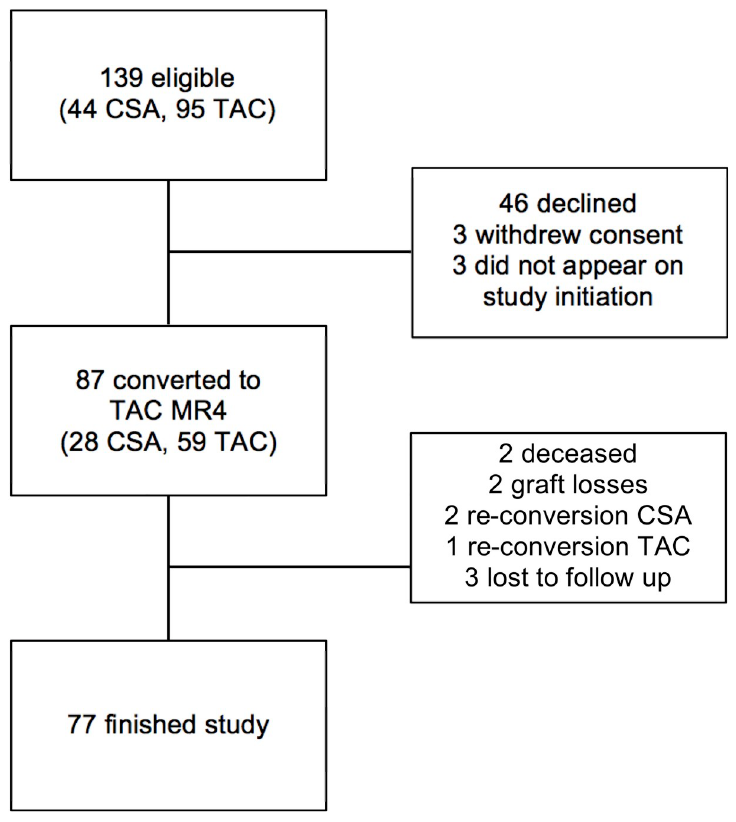
Fig 1. Patient disposition of the Vienna prograf and endothelial progenitor cell extension study (PEP-X). CSA = ciclosporin, TAC = tacrolimus, TAC MR4 = tacrolimus modified